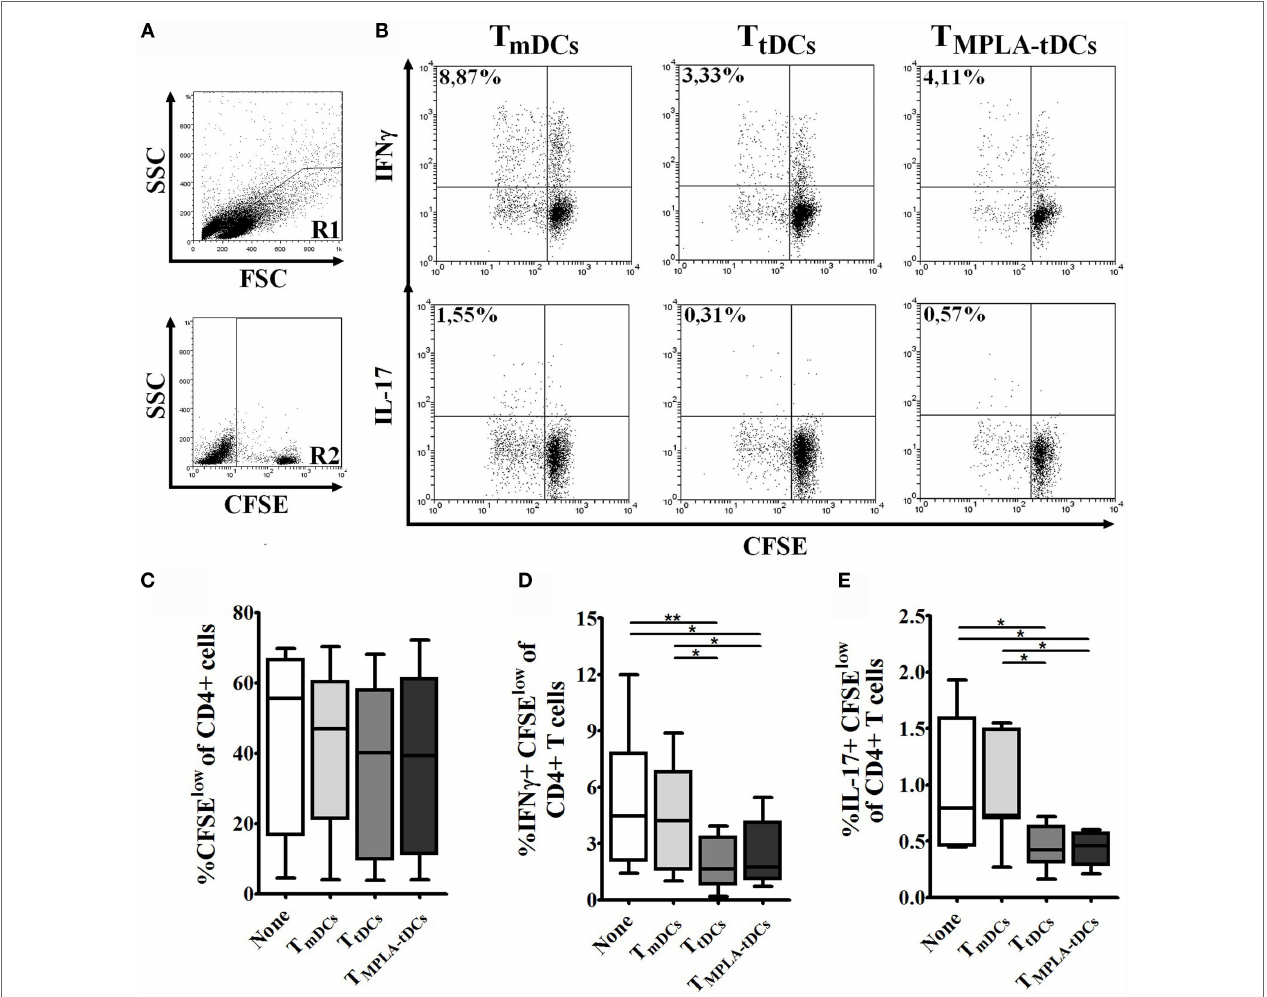
FigUre 5 | MPla-tDcs endow naive cD4 + T cells with the ability to suppress Th1 and Th17 responses . To evaluate the ability of MPLA-tDCs to induce functional regulatory properties on naive CD4 + T cells, these cells were primed with PPD-loaded DC subsets and then were recovered, washed, and added to a co-culture of CFSE-labeled responder CD4 + T cells and PPD-pulsed mDCs. Responder CD4 + T cells co-cultured with mDCs and without the addition of primed- naive CD4 + T cells were used as control. (a) Gate strategy is shown: R1 = lymphocytes region, R2 = CFSE + population. (B) Representative dot plots of IFN- γ (top) and IL-17 (bottom) expression from seven independent experiments are shown. (c) Proliferation of responder CD4 + T cells in presence of primed-naive CD4 + T cells was determined by CFSE dilution through flow cytometry, and graphic representation of the percentage of CFSE low in CD4 + T cells is shown. (D) IFN- γ and (e) IL-17 expression were detected intracellularly and analyzed by flow cytometry. Graphic representation of the percentage of IFN- γ and IL-17 producing proliferating CD4 + T cells (CFSE low ) is shown. For (c–e) , statistical differences were calculated using one-way ANOVA followed by Tukey post-test (* P < 0.05; ** P <